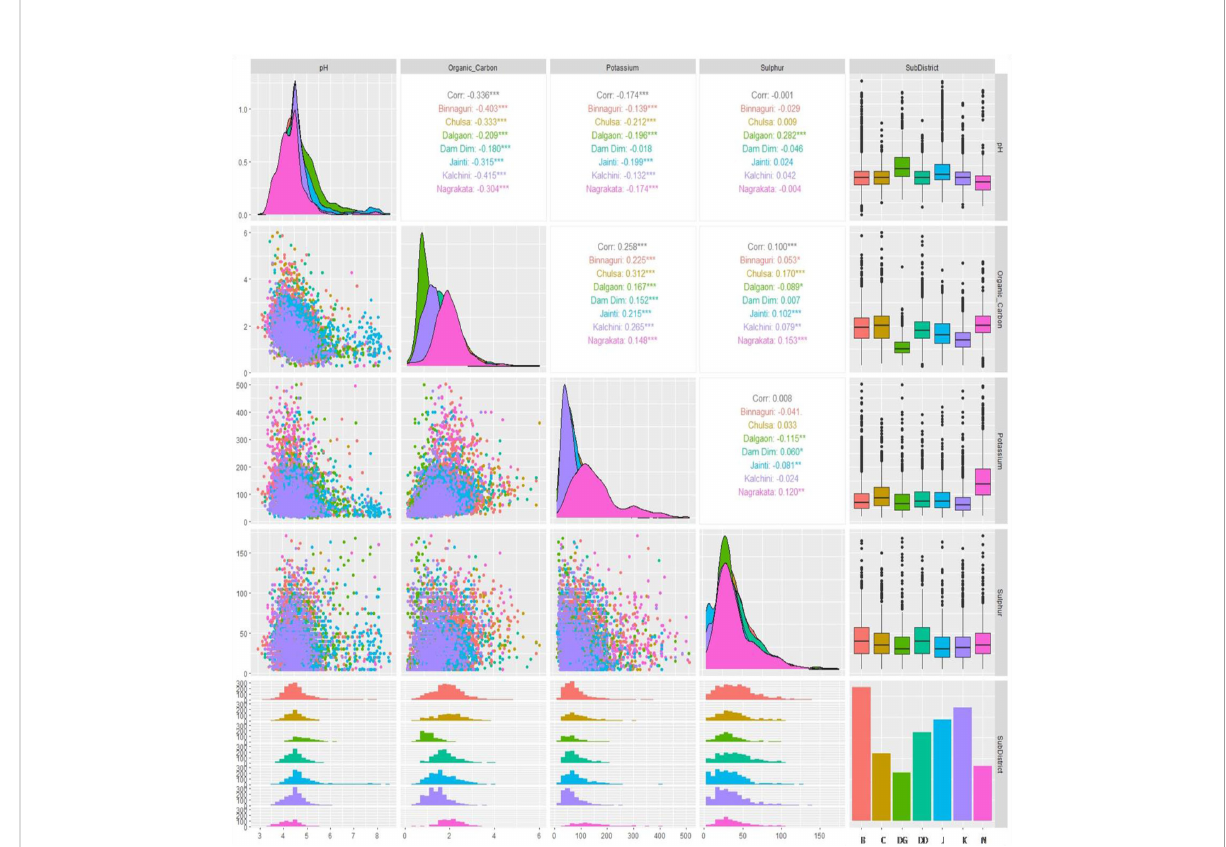
FIGURE 3 Sub-district wise bivariate correlations of reported soil parameters (pH, organic carbon, available potassium, and available sulphur) of 7300 analyzed soil samples represented by box plot, density, scatter, histogram, and bar diagram (in bar diagram B, Binnaguri; C, Chulsa; DG, Dalgaon; J, Jainti; K, Kalchini and N, Nagrakata; here ‘ Organic_Carbon ’ is ‘ OC ’ , ‘ Potassium ’ is ‘ available potassium (K) as K 2 O ’ abbreviated as ‘ AK ’ and Sulphur is ‘ available sulphur ’ abbreviated as ‘ AS ’ in the manuscript; signi fi cance codes: “ *** ” at 0.001%, “ ** ” at 0.01% and “ * ” at 0.05%